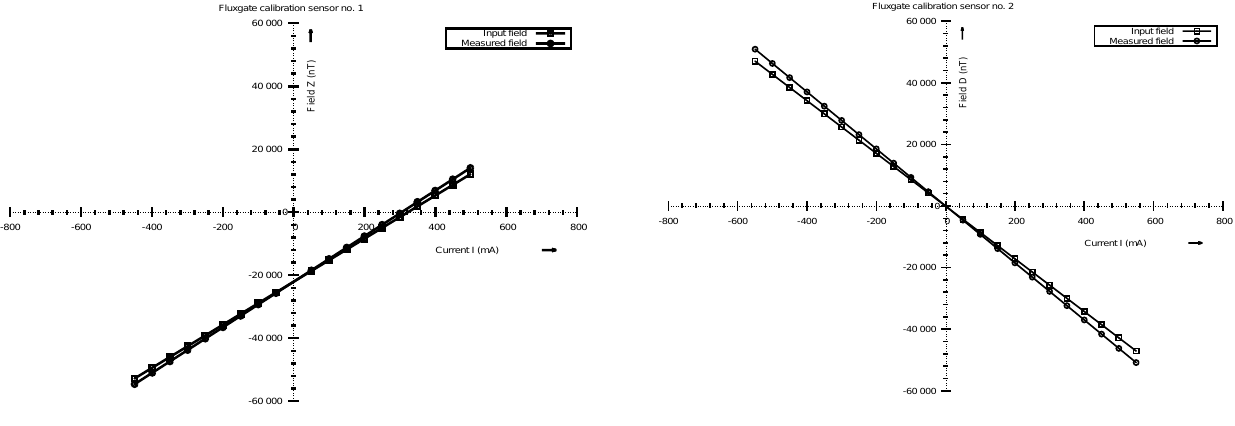
Figure 13. Fluxgate calibration using a d coil (sensor no. 2).